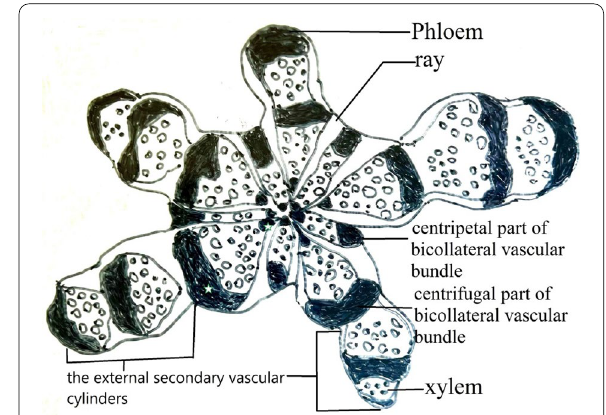
Fig. 5 The bicollateral vascular bundle (Cucurbitaceae) with outer and inner phloem at both ends. White stars are inner and outer